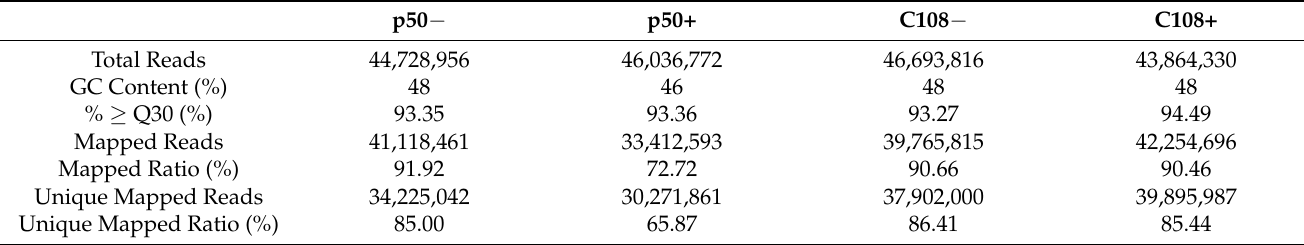
Table 3. Summary statistics for silkworm genes based on RNA-seq